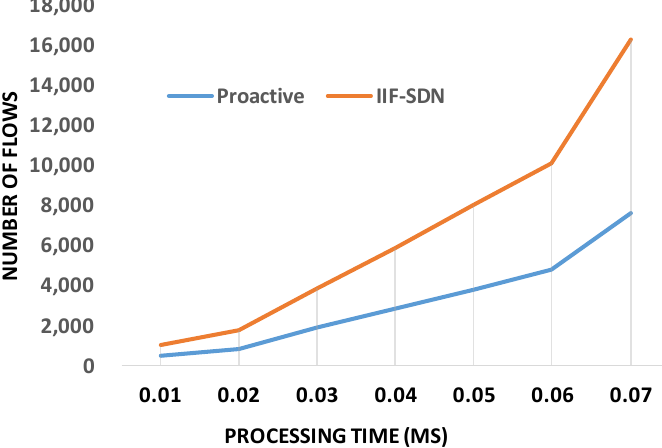
Figure 14. Multiple SDN nodes ’ flow-rule exchange.